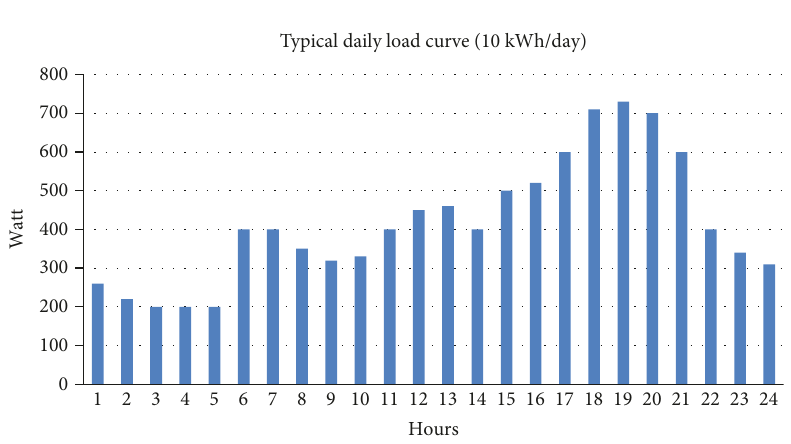
Figure 4: Typical daily load curve of a residential house in Gaza used in the simulation